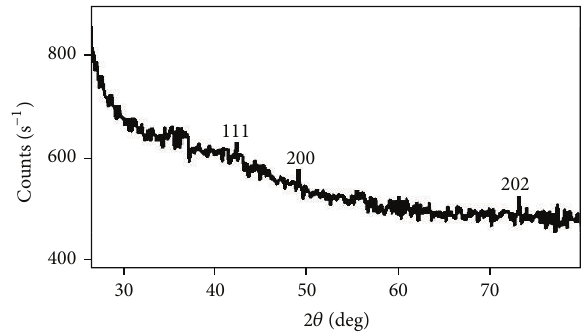
Figure 6: XRD pattern of FeNPs synthesized using Gardenia leaves extract.